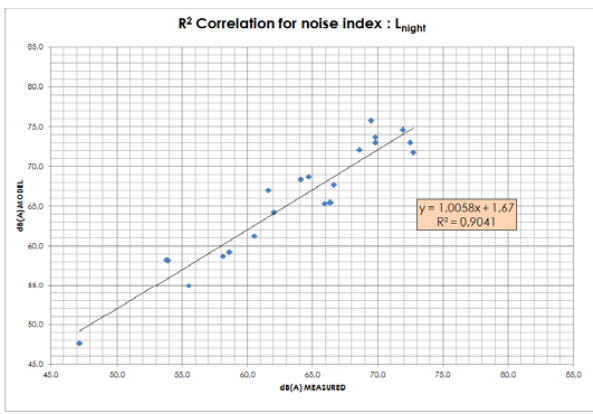
Figure 5: R 2 Correlation for noise index: L the HAP is based on are described in “Refined noise score rating model for residents”